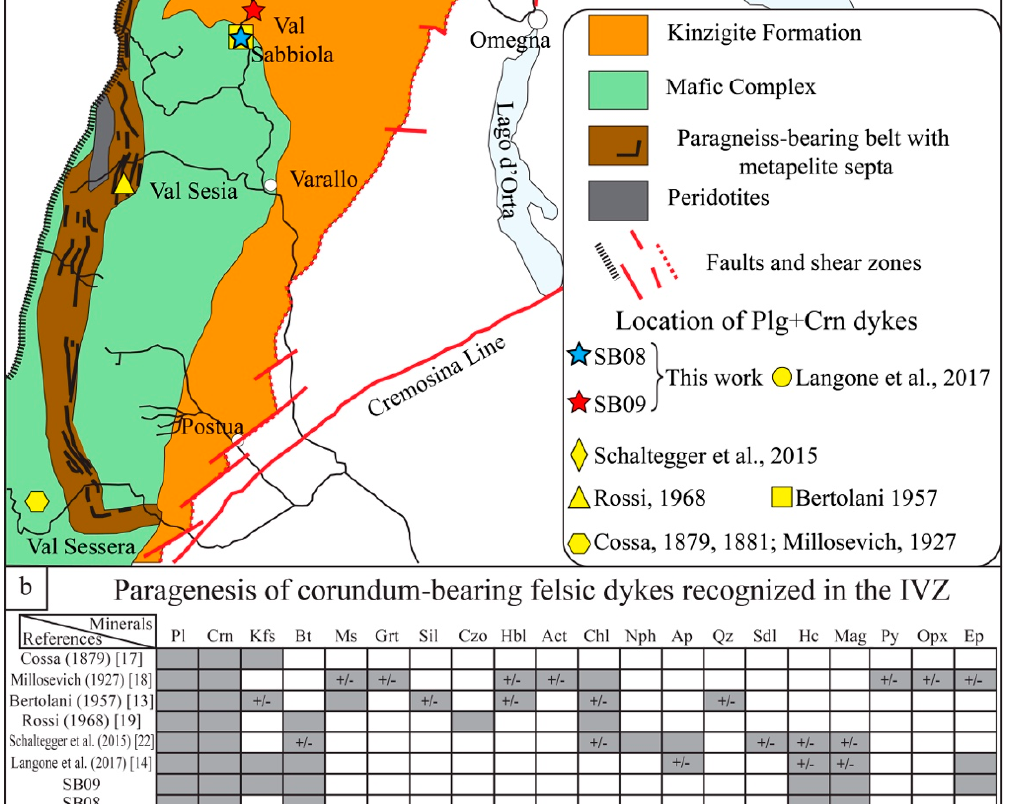
Figure 1. ( a ) geologic map of the Ivrea–Verbano Zone (modified after, Zingg [23] and Sinigoi [24]). The map shows the location of corundum-bearing dykes of the Ivrea–Verbano Zone (IVZ). ( b ) schematic table showing the mineral assemblages described for the felsic dykes in different samples and localities of the IVZ. Grey filled boxes indicate the common of local (+/-) occurrence of a mineral phase within the dyke. Abbreviations after Whitney and Evans [25].